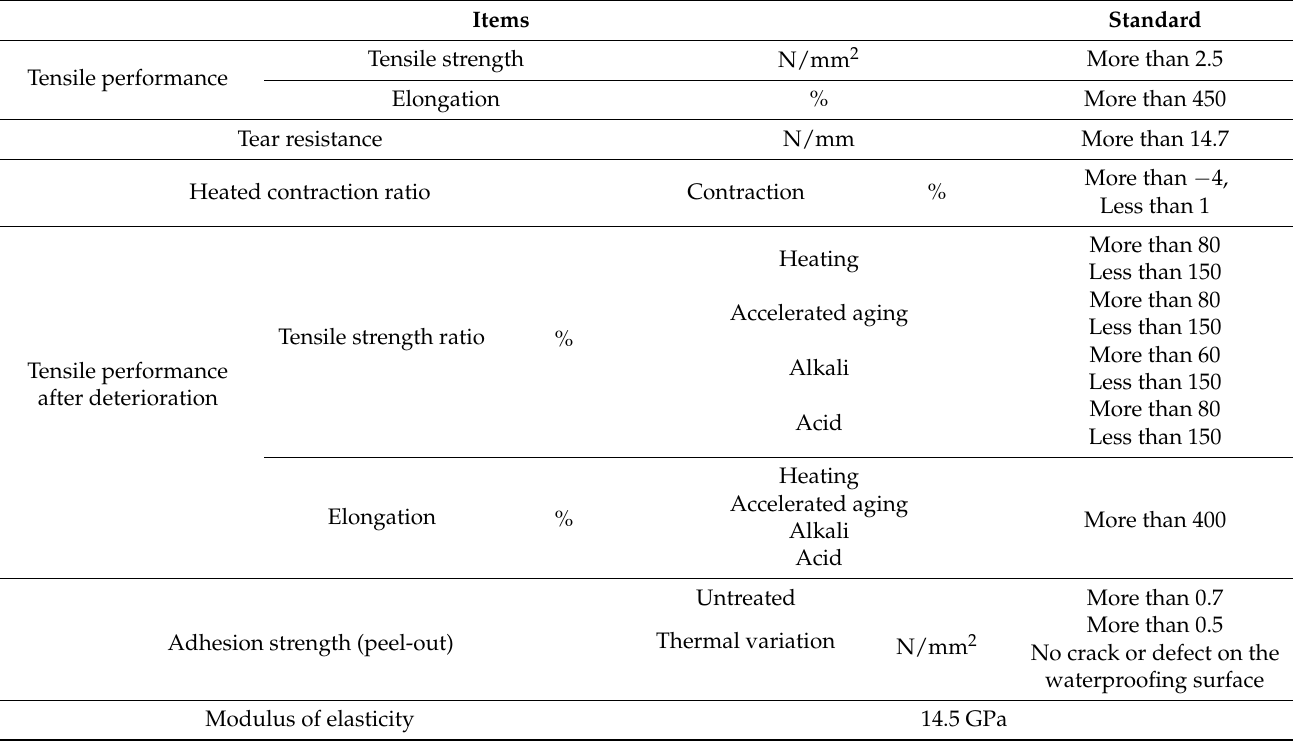
Table 1. Poly-urethane coating (PUC) specification.